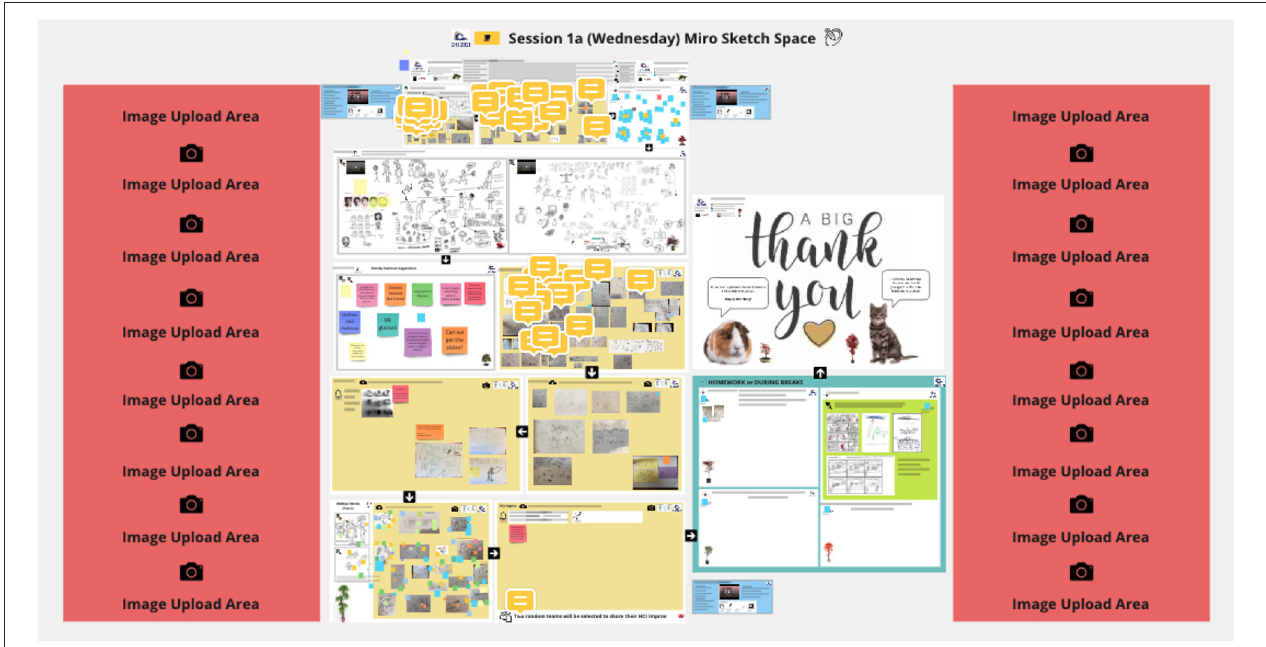
FIGURE 12 | Example interactive Miro board from ACM CHI 2021. Makayla Lewis and Miriam Sturdee, 2021.